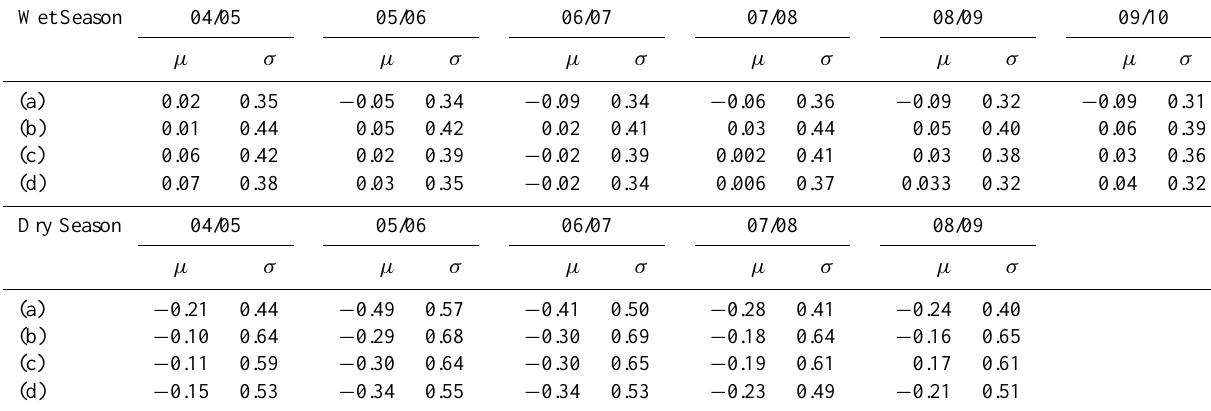
Table 7. Mean ( µ – mmday − 1 ) and standard deviation ( σ – mmday − 1 ) of the difference between ASCE-PM ET 0 estimates at the Guadalfeo river watershed and different alternatives per hydrological year: (a) IDW to Hargreaves estimates at each station with adjusted c H , (C- I method type) (b) distributed computation of Hargreaves equation with adjusted c H allocated to regions of influence (c) distributed compu- tation of Hargreaves equation with adjusted c H allocated to modified regions of influence (d) distributed computation of Hargreaves equation with IDW to adjusted c H